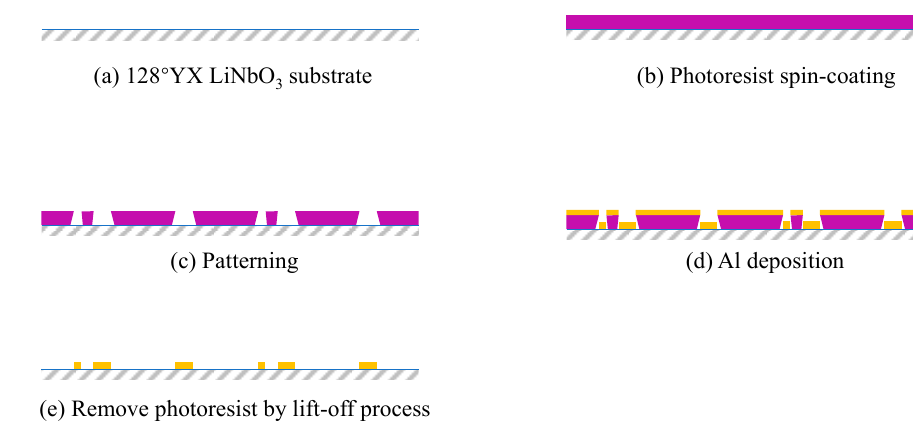
Figure 7. Fabrication procedure for a test device.